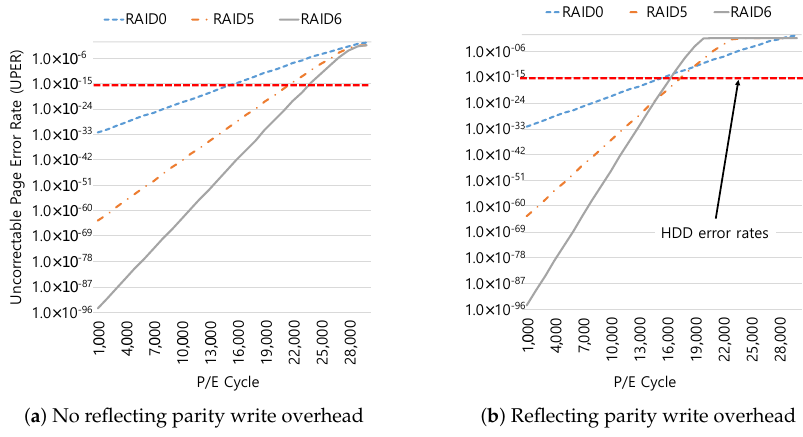
Figure 1. Comparison of the error rate according to the parity write cost in an